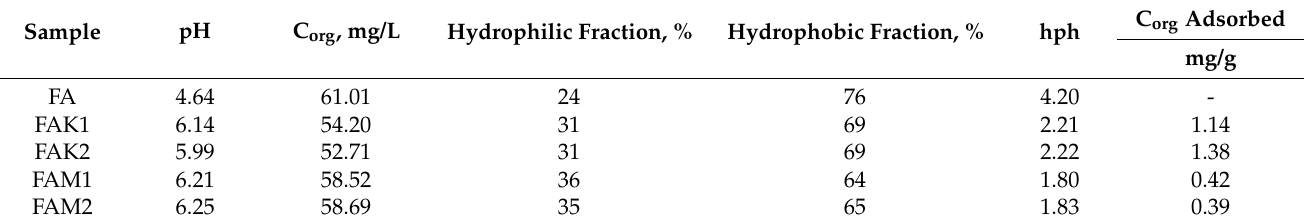
The water extract from the H horizon had an acidic reaction of the medium (pH 4.58), Table 2. The FA solution properties before and after adsorption on minerals and the amount of C org adsorbed. where the concentration of C org was 337.06 mg/L. The molecular weight distribution is rep- resented by one well-pronounced peak corresponding to a molecular weight of 21,000 Da (Figure 3A). According to the amphiphilic distribution curve, hydrophilic components are Sample represented by a narrow peak and hydrophobic ones by three partially overlapping peaks (Figure 3B). Hydrophobic components prevailed over hydrophilic ones both in the water extract from the H horizon and in the FA solution; however, the WEOM hydrophobicity coefficient is less than that of FA and is equal to 1.43 units (Table 3). The close similarity of WEOM and FA molecular sizes indicates that WEOM components are mainly represented by FA.